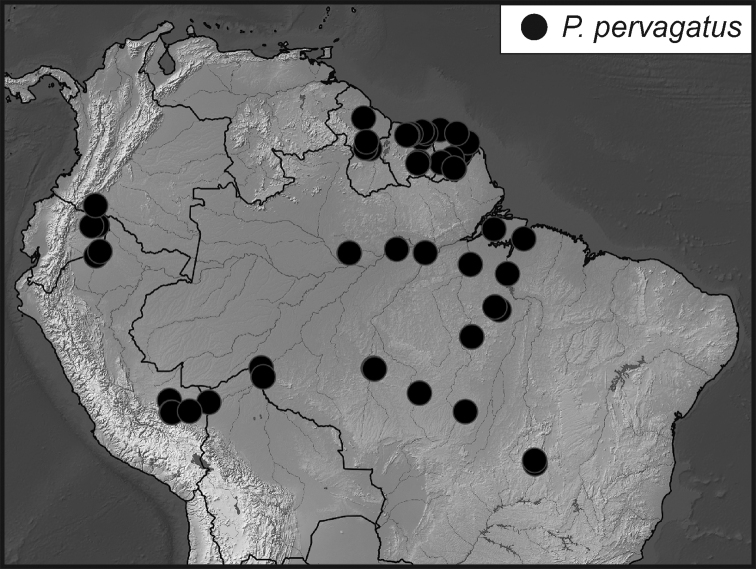
Collecting records for Phelister
pervagatus.